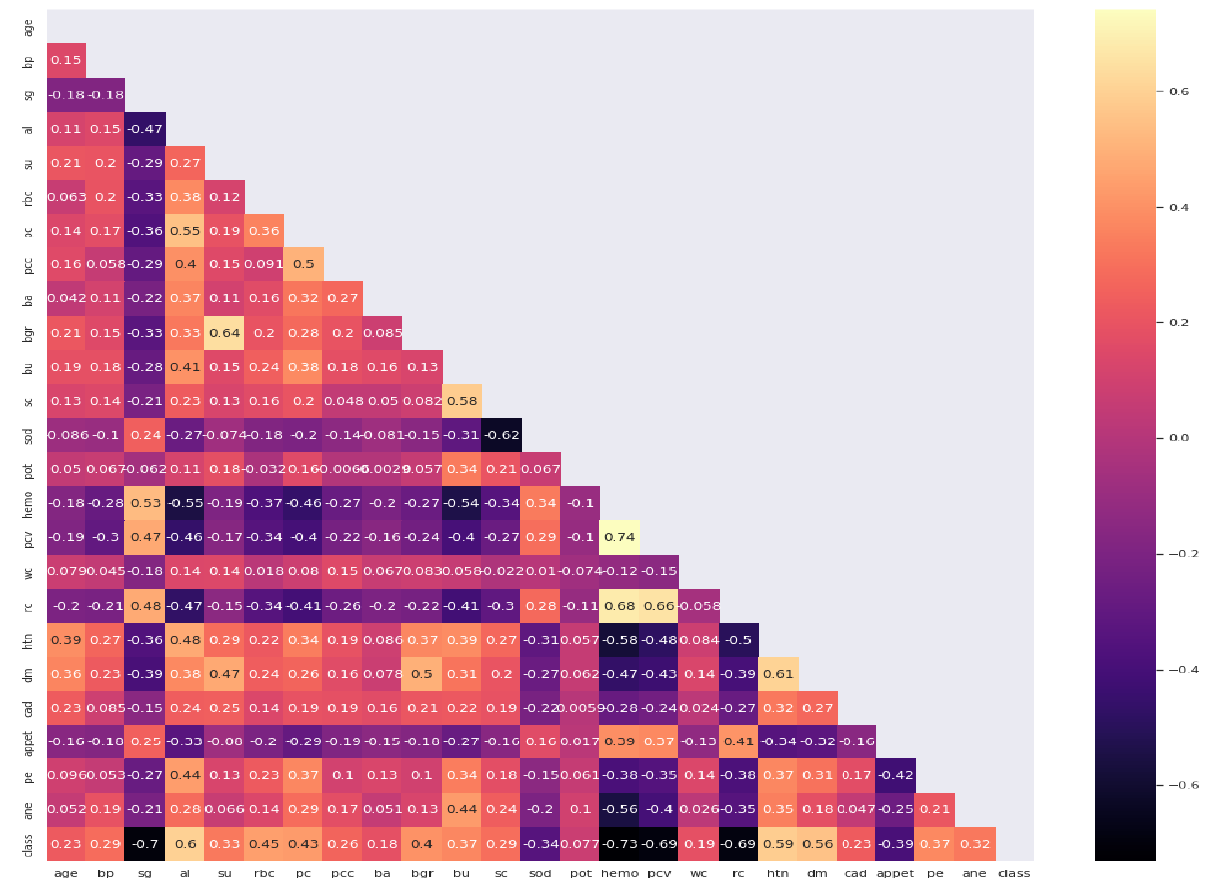
Figure 2. Highly correlated features of CKD dataset.